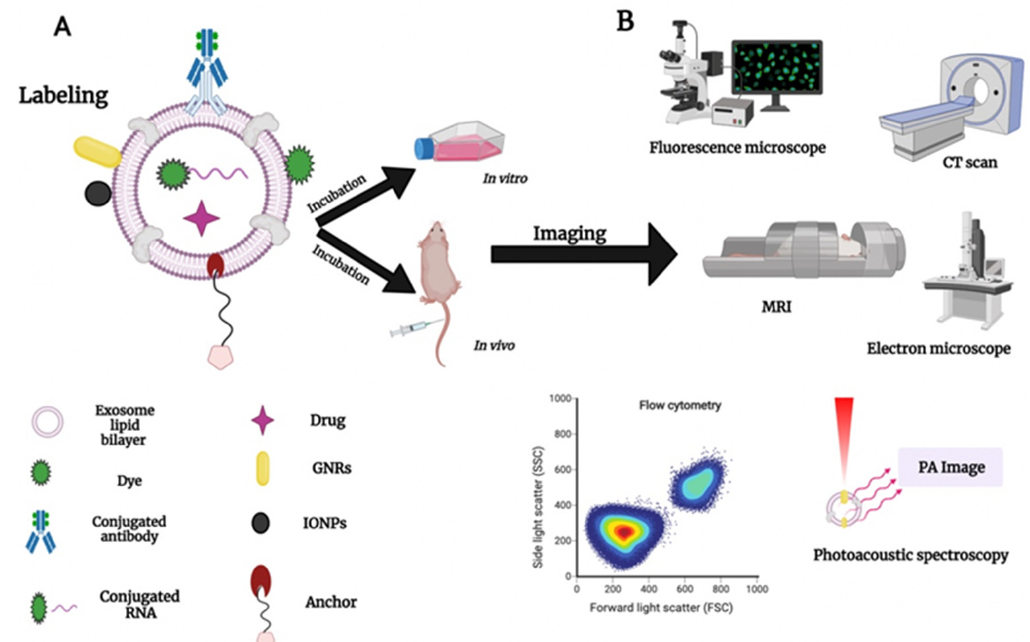
Figure 11. Illustration of labeling exosomes with different probes and NPs ( A ), and different instruments that can be used to image exosomes in vitro and in vivo ( B ). Here, fluorescence microscopy is used as an example for all types of fluorescence-based imaging technique. In addition, a number of other imaging modalities can be employed when exosomes have proper nanomaterial labeling. GNRs: Gold nanorod; IONPs: Iron oxide nanoparticles.